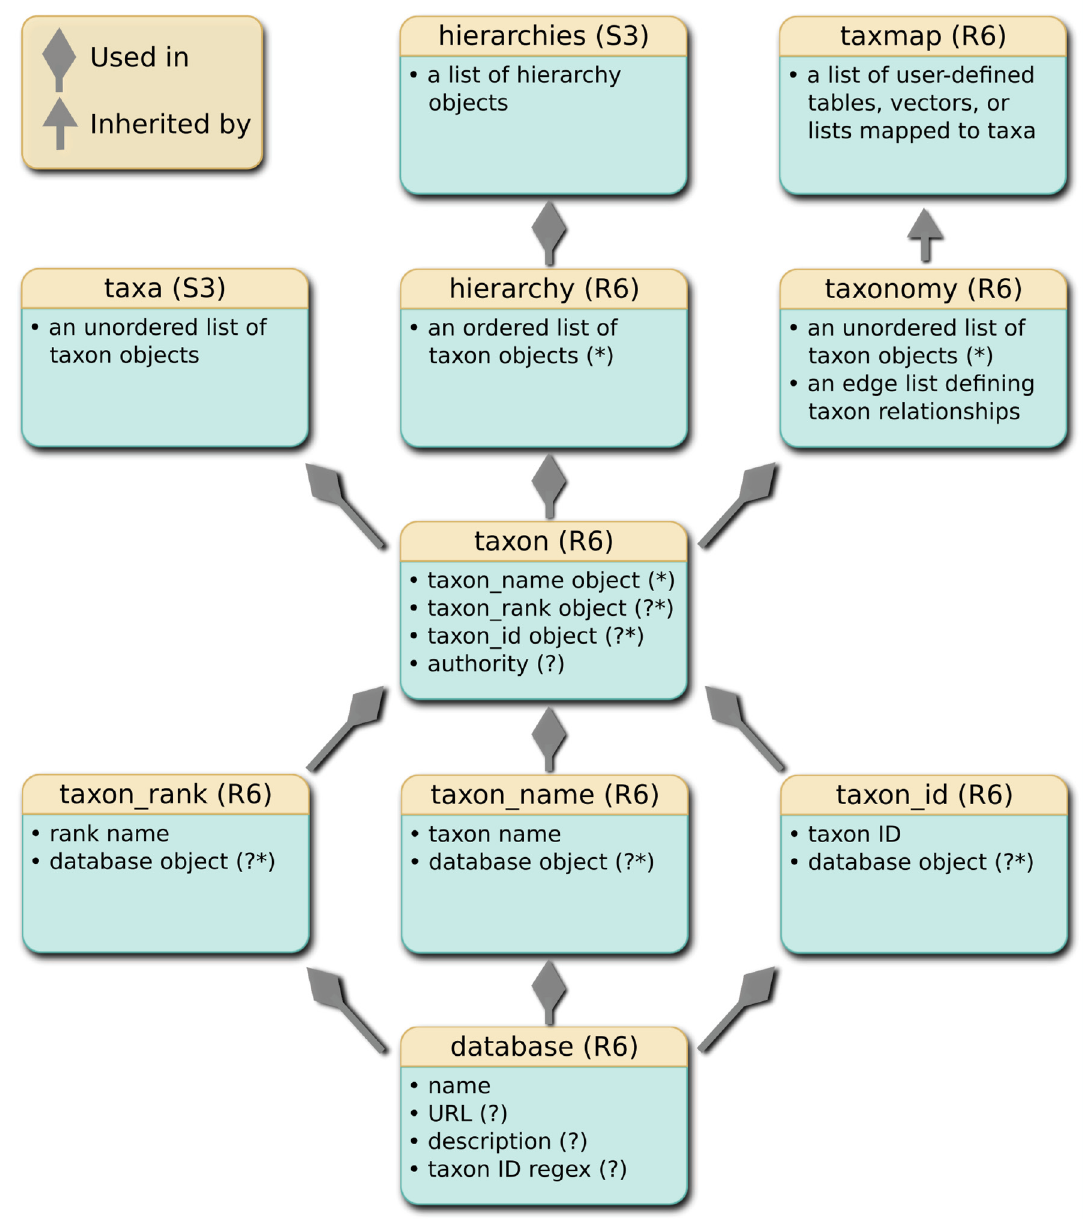
Figure 1. A class diagram representing the relationship between classes implemented in the taxa package. Diamond-tipped arrows indicate that objects of a lower class are used in a higher class. For example, a database object can be stored in the taxon_rank , taxon_ name , or taxon_id objects . A standard arrow indicates that the lower class is inherited by the higher class. For example, the taxmap class inherits